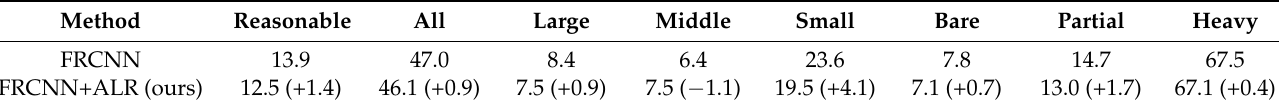
Table 5. Comparison of FRCNN+ALR with baseline across each subset of the CityPersons validation set (MR − 2 /%).